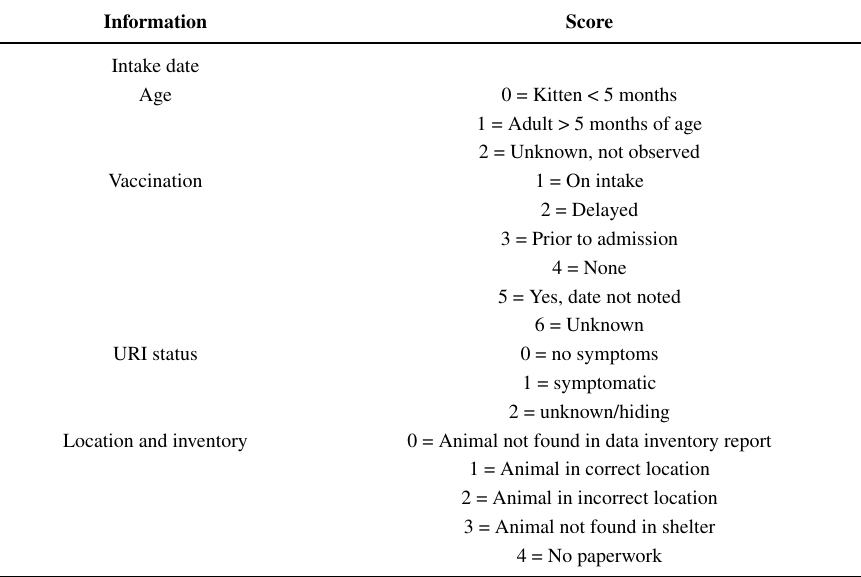
Table 1. Data points collected by